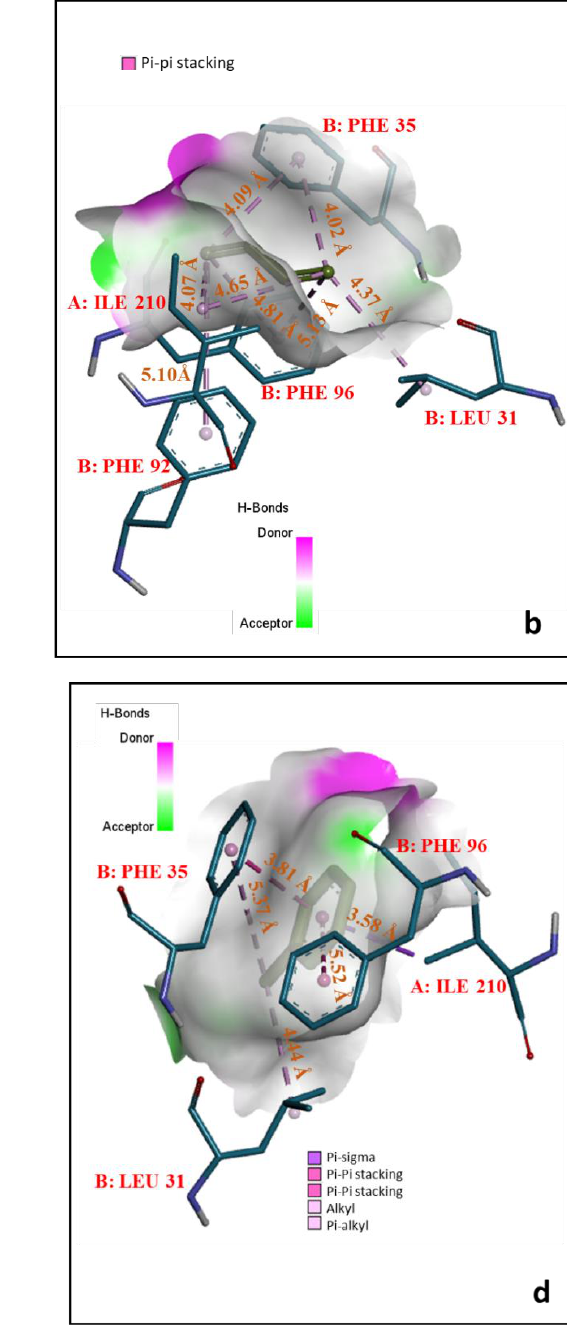
Figure 5. Pocket site interactions between the modeled pMMO and ( a ) ethylbenzene, ( b ) toluene ( c ) 1,3-butadiene, and ( d ) trichloroethylene. The alkyl bonds, conventional hydrogen bonds, Pi-alkyl, and Pi-sigma stacking are shown in light pink, green, dark red, and yellow, respectively. The regions of the pocket sites are then validated using multiple sequence alignment in MEGA v10 to examine the chances of conservation in different methanotrophic genera as shown in Figure 6. The multiple sequence alignment performed between 13 metha- notrophic genera that belong to the α - proteobacteria, γ -proteobacteria, and Verrucomi- crobia shows that the conserved domain residues are hydrophobic and non-polar, and they are the same as the interacting residues. According to the hydrophobicity index of the amino acid residues surrounding the pocket sites, the residues are nonpolar and hy- drophobic, which contributed to the non-electrostatic bonds between them and the sub- strates. However, the partial charged bonds such as convectional hydrogen bonds and electrostatic bonds are also observed on the side layers of amino acid residues surround- ing the pocket sites. The electrostatic and non-electrostatic bonds together formed an in- tact enzyme-substrate complex [55,56]. Furthermore, no allosteric sites were recorded within the enzyme with regard to the arrangement of amino acids and binding energies observed with the pocket sites. The binding energies between the substrates and pocket sites are considerably too low to participate in allosteric inhibition [57]. Thus, the binding energy approach, hydrophobicity and multiple sequence alignment data suggest that PS1, PS2, PS3, and PS4 are active sites in monomeric pMMO. Interestingly, these pocket sites do not contain copper centers. Therefore, the role of copper center, and the mechanisms of involvement of copper during methane oxidation, remains unclear and needs to be elu- cidated